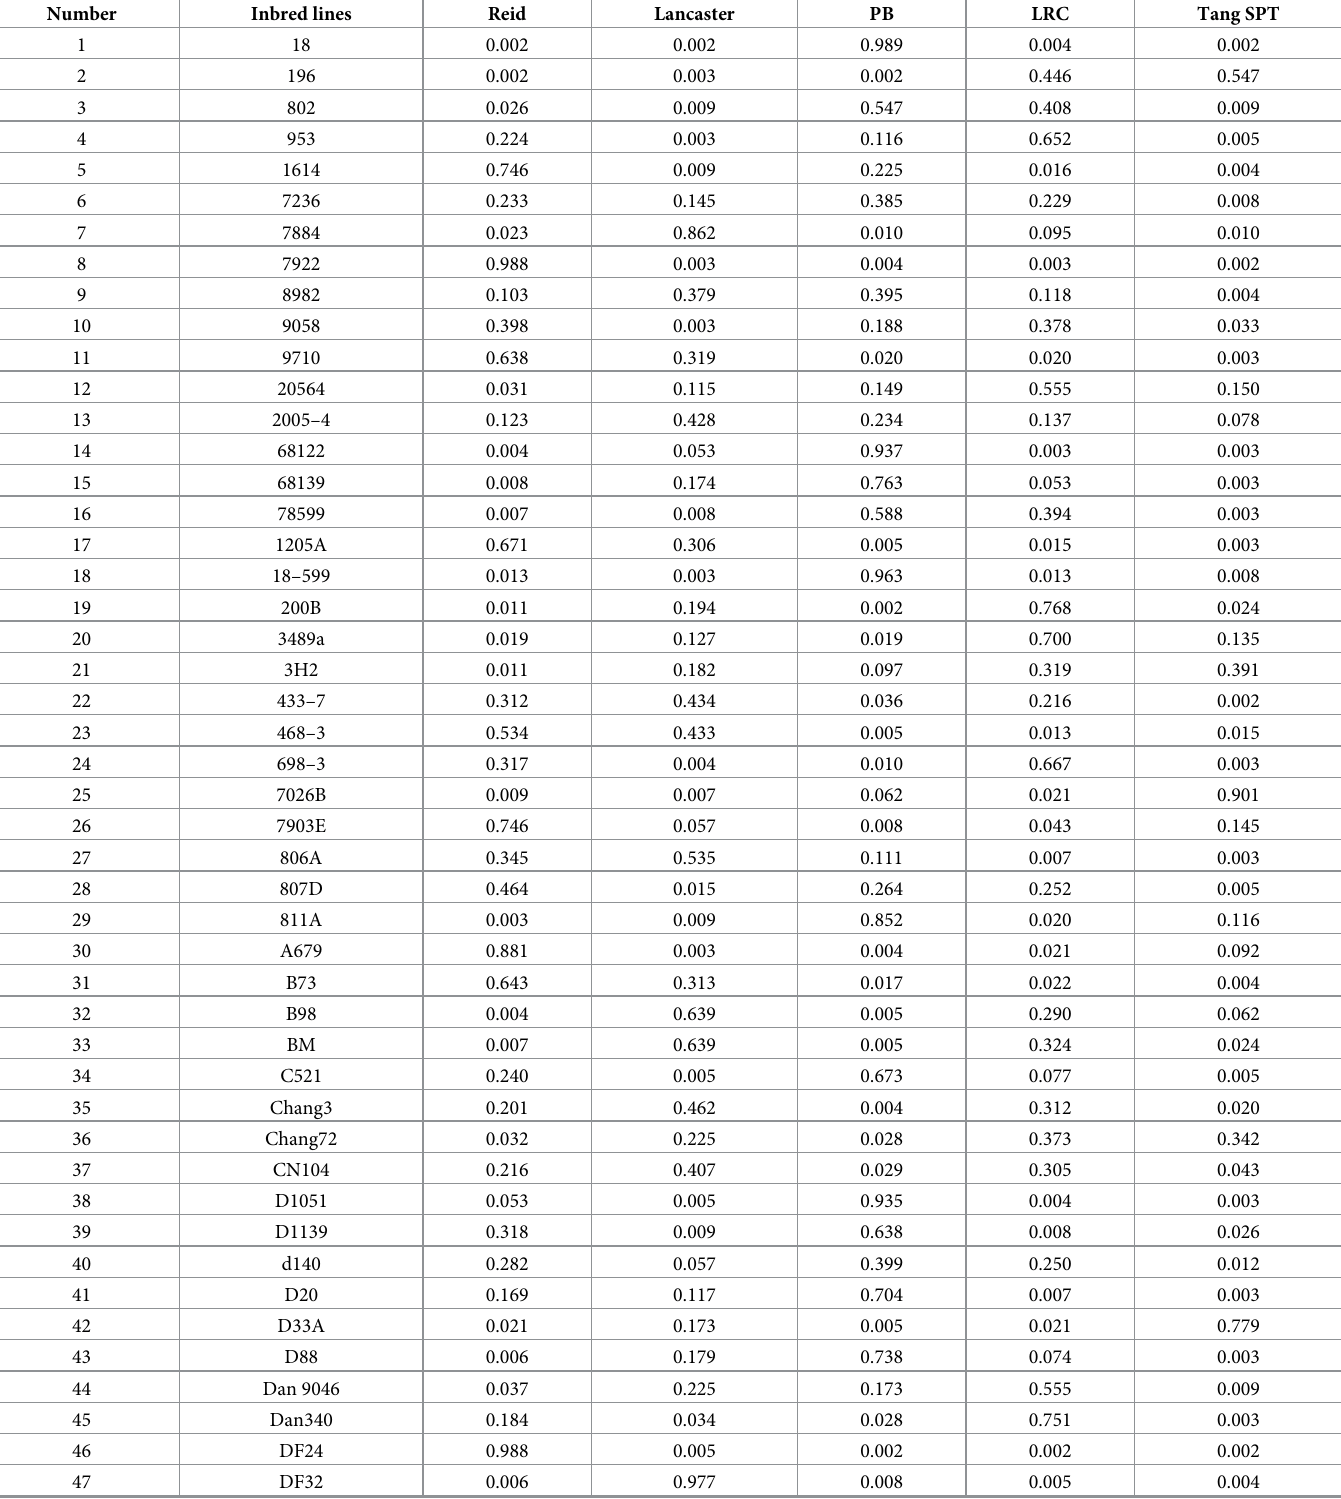
Table 3. Q-values of 120 inbred